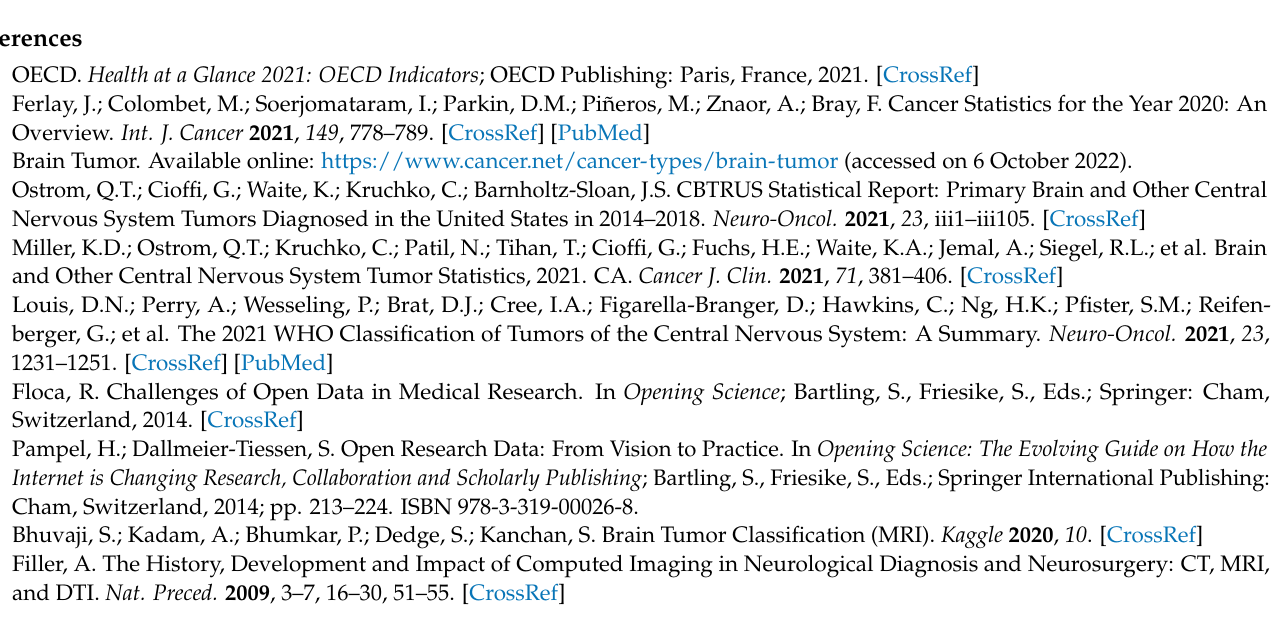
Figure A6. Confusion Matrices for simple Vision Transformer ( left ) pre-trained Vision Transformer ( right ).